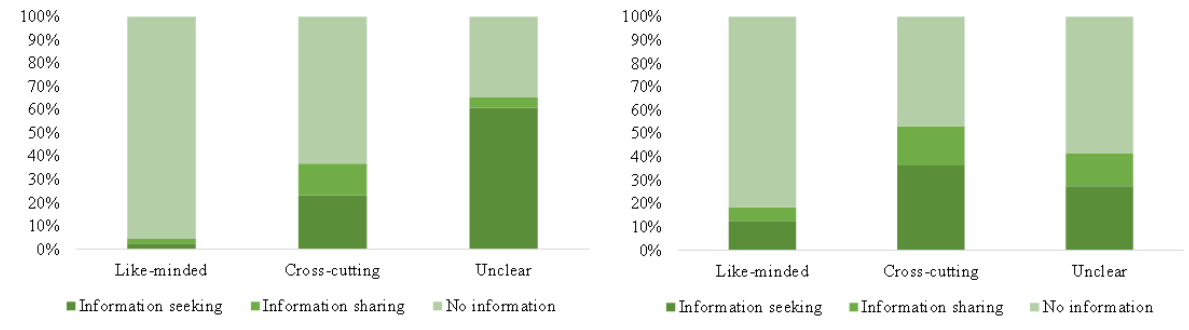
Figure 9. The proportion of information-seeking, information-sharing, and no information content in different kinds of interactions in retweets (left) and comments